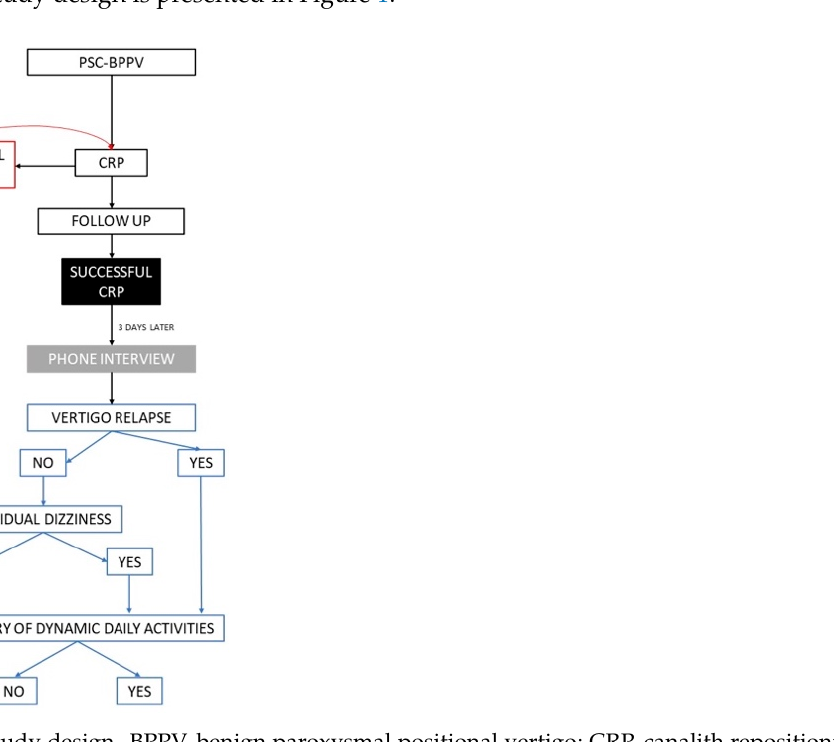
Figure 1. Study design. BPPV, benign paroxysmal positional vertigo; CRP, canalith repositioning procedure; PSC-BPPV, posterior semicircular canal BPPV.